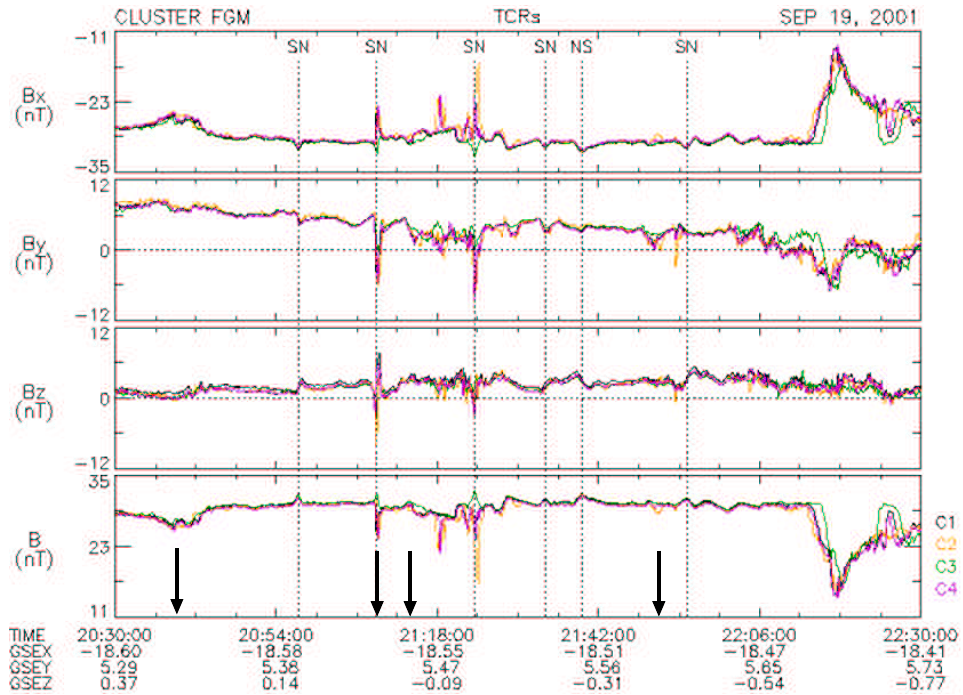
Fig. 12. FGM magnetic field data with vertical dashed lines pointing out the occurrence of TCRs. SN TCRs are observed at 20:57:20, 21:08:58, 21:23:32, 21:34:06, and 21:55:10 UT, and a single NS TCR occurs at 21:39:35 UT. The substorm onset and intensification times as determined from ground-based magnetic field data are marked with the black arrows in the bottom